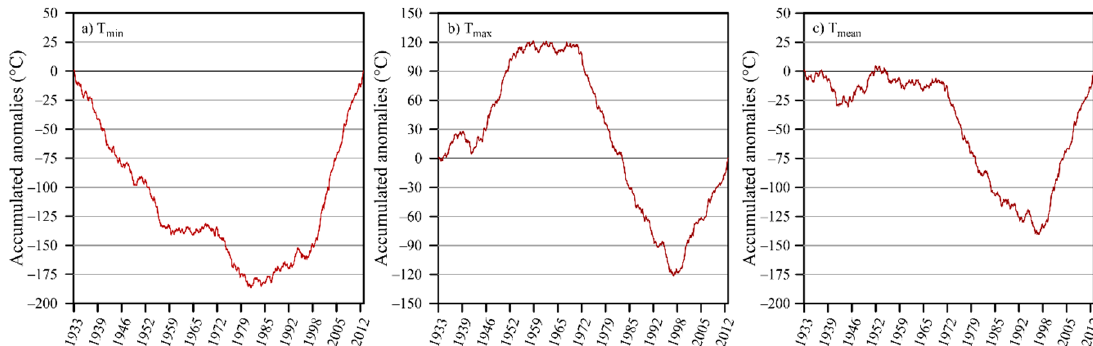
Figure 3. Accumulated anomalies of the monthly minimum (T min , ( a )), maximum (T max , ( b )) and mean (T mean , ( c )) temperature records for the Salento area.